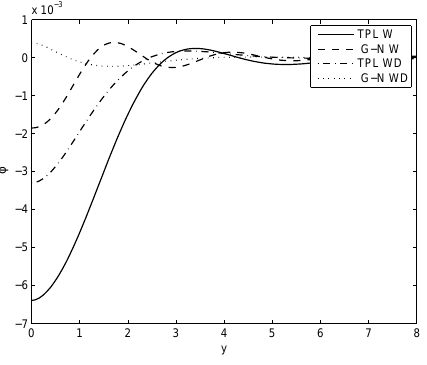
Fig. 2 Distribution the temperature function φ with and without